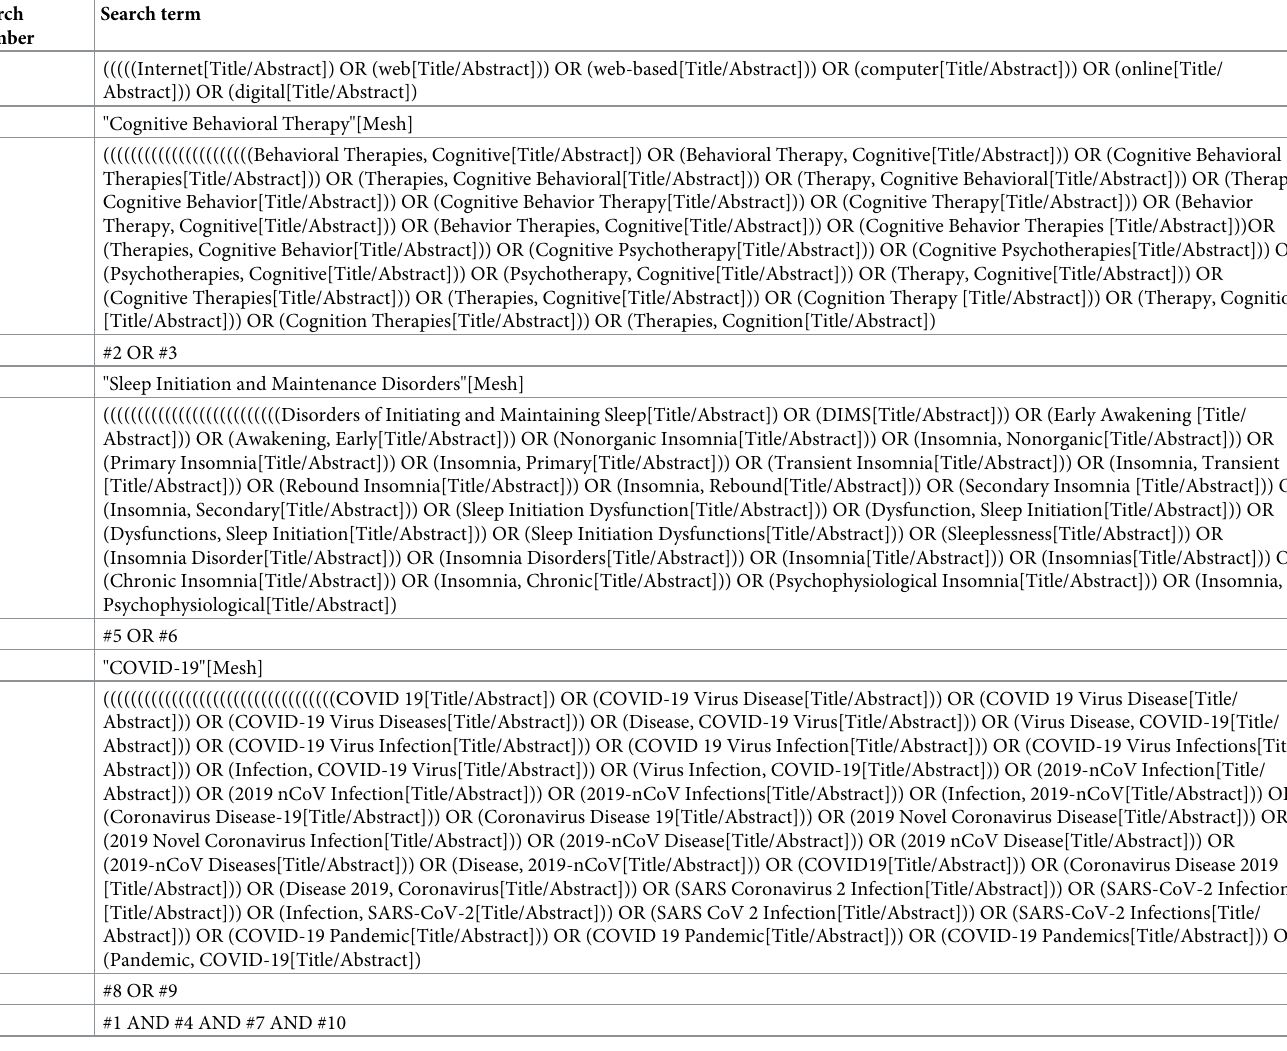
Table 1. Search strategy for